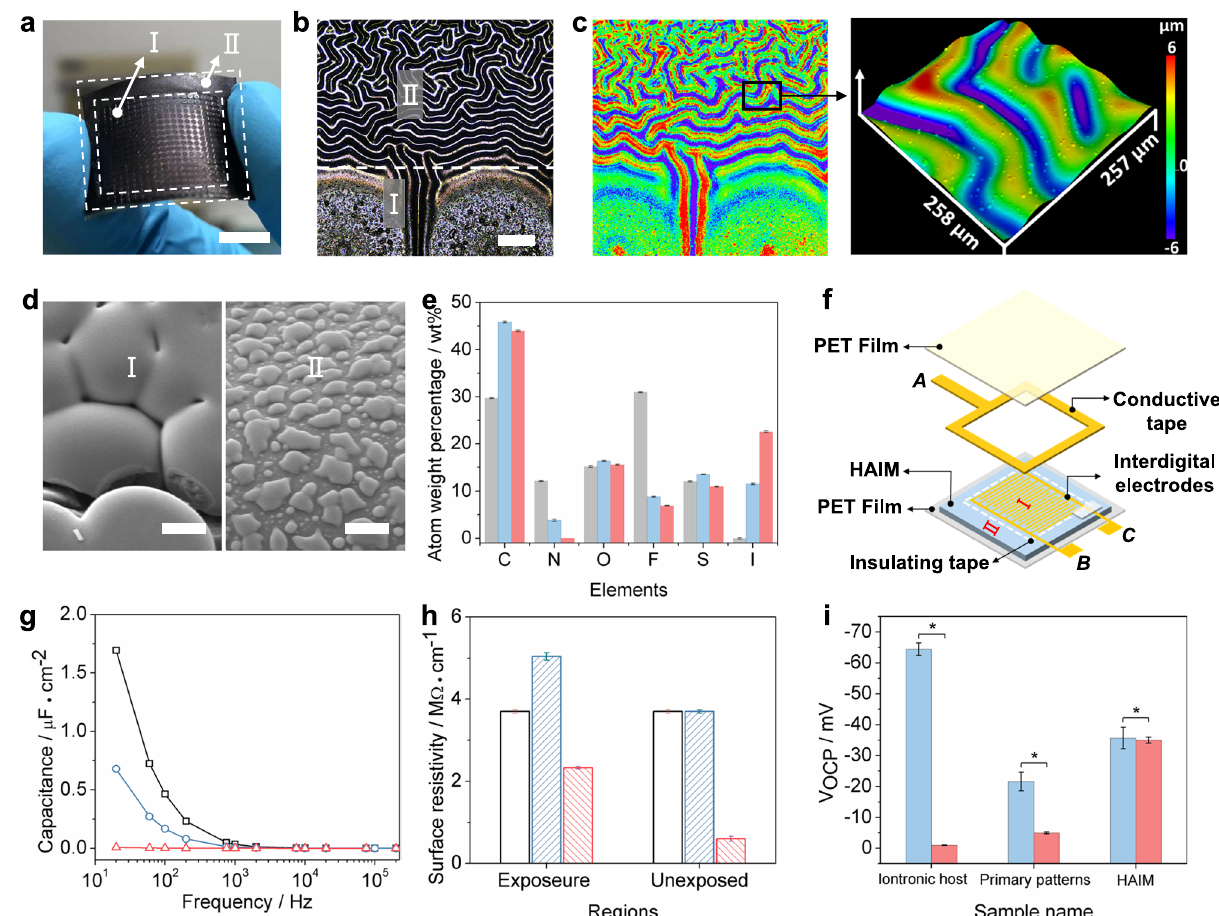
g Capacitance changes versus frequencyfor pristine iontronic host (black line), IL- doped PEDOT @primary patterns (gray-blue line), and resultant HAIM (red line), respectively. h Surface resistivity of different regions in pristine iontronic host (blackframe),IL-dopedPEDOT@primarypatterns(gray-blueframe),andresultant HAIM(redframe),respectively.Errorbarsrepresentthestandarddeviationsof fi ve independent data. i Potential gradients changes of different samples within a lim- itedtimeinterval(gray-bluecolumn,redcolumn,andasteriskwereinitialpotential, fi nal potential, and 1min interval, respectively). Error bars represent the standard deviations of three independent